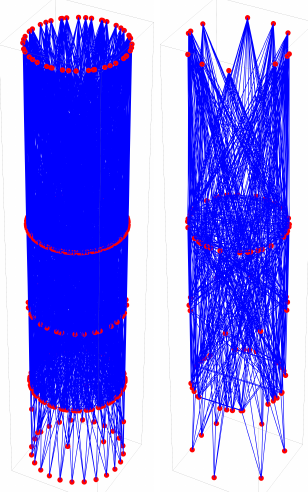
Figure 7. ¯ G 1260 and ¯ G 315 . The p values associated with these graphs differ by a factor of 2 2 and hence have equal saturation